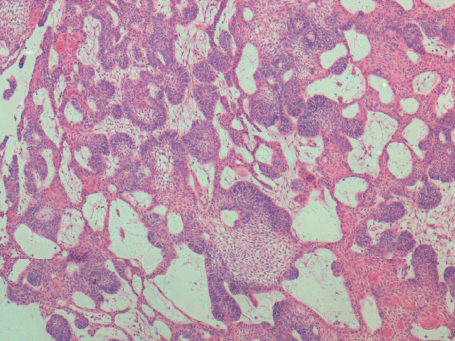
Figure 5: IHC Ki-67 mildly positive in fewer